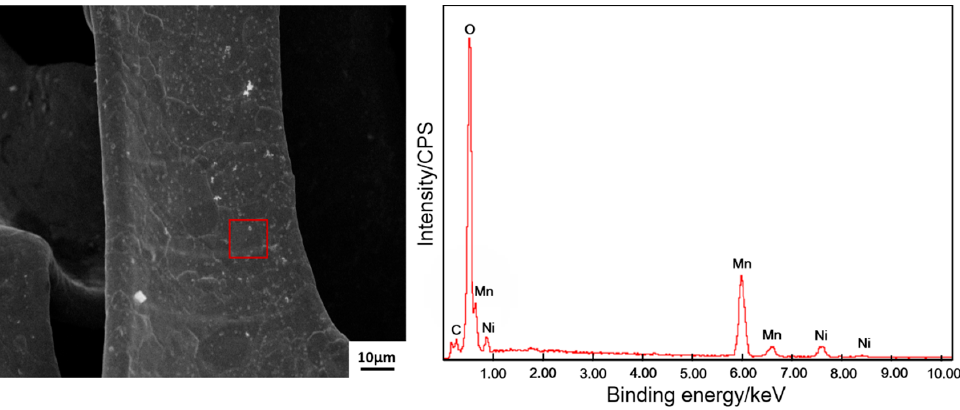
Figure 8. The SEM image of the electrode surface after depositing for 120 s and the EDS result for the selected zone as marked with a red square.